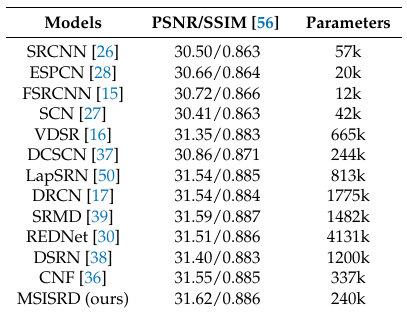
Table 3. Quantitative results of computational complexity in terms of number of parameters versus PSNR [56] on Set5 [62] with 4 × scale enlargement factor